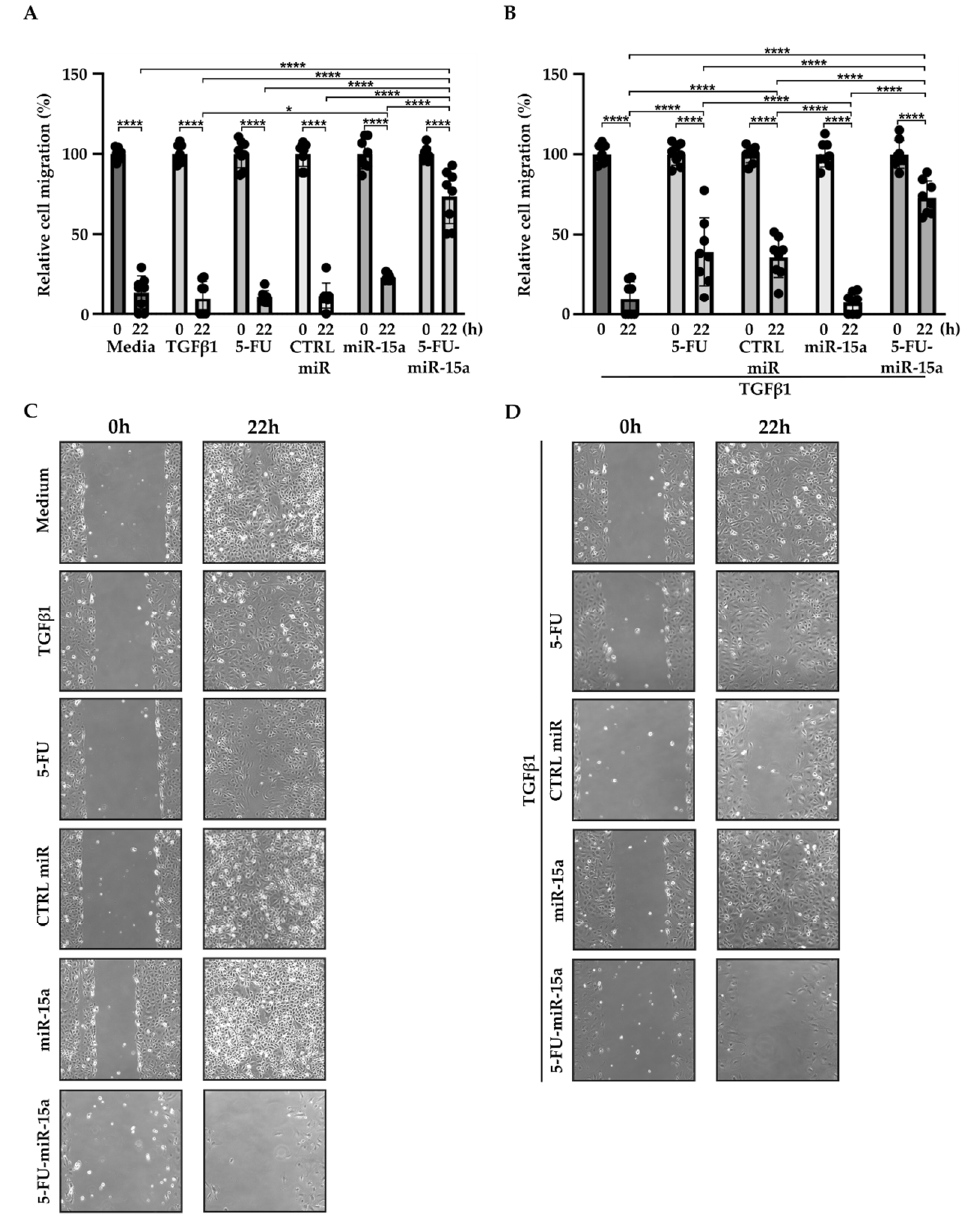
Figure 7. 5-FU-miR-15a inhibits the migration of pancreatic stellate cells as a single agent and in the context of TGF β 1 treatment. Pancreatic stellate cells were treated with TGF β 1, and/or 5-FU, CTRL miR, miR-15a, and 5-FU-miR-15a. Migration was assessed 22 h post-scratch ( A )–quantitative analysis and ( B ) representative images after single agent treatment, and ( C )–quantitative analysis and ( D ) representative images after co-treatment with TGF β 1. Data are represented as the mean ± SD, N = 8. * p < 0.05 and **** p < 0.0001 by One-Way ANOVA.